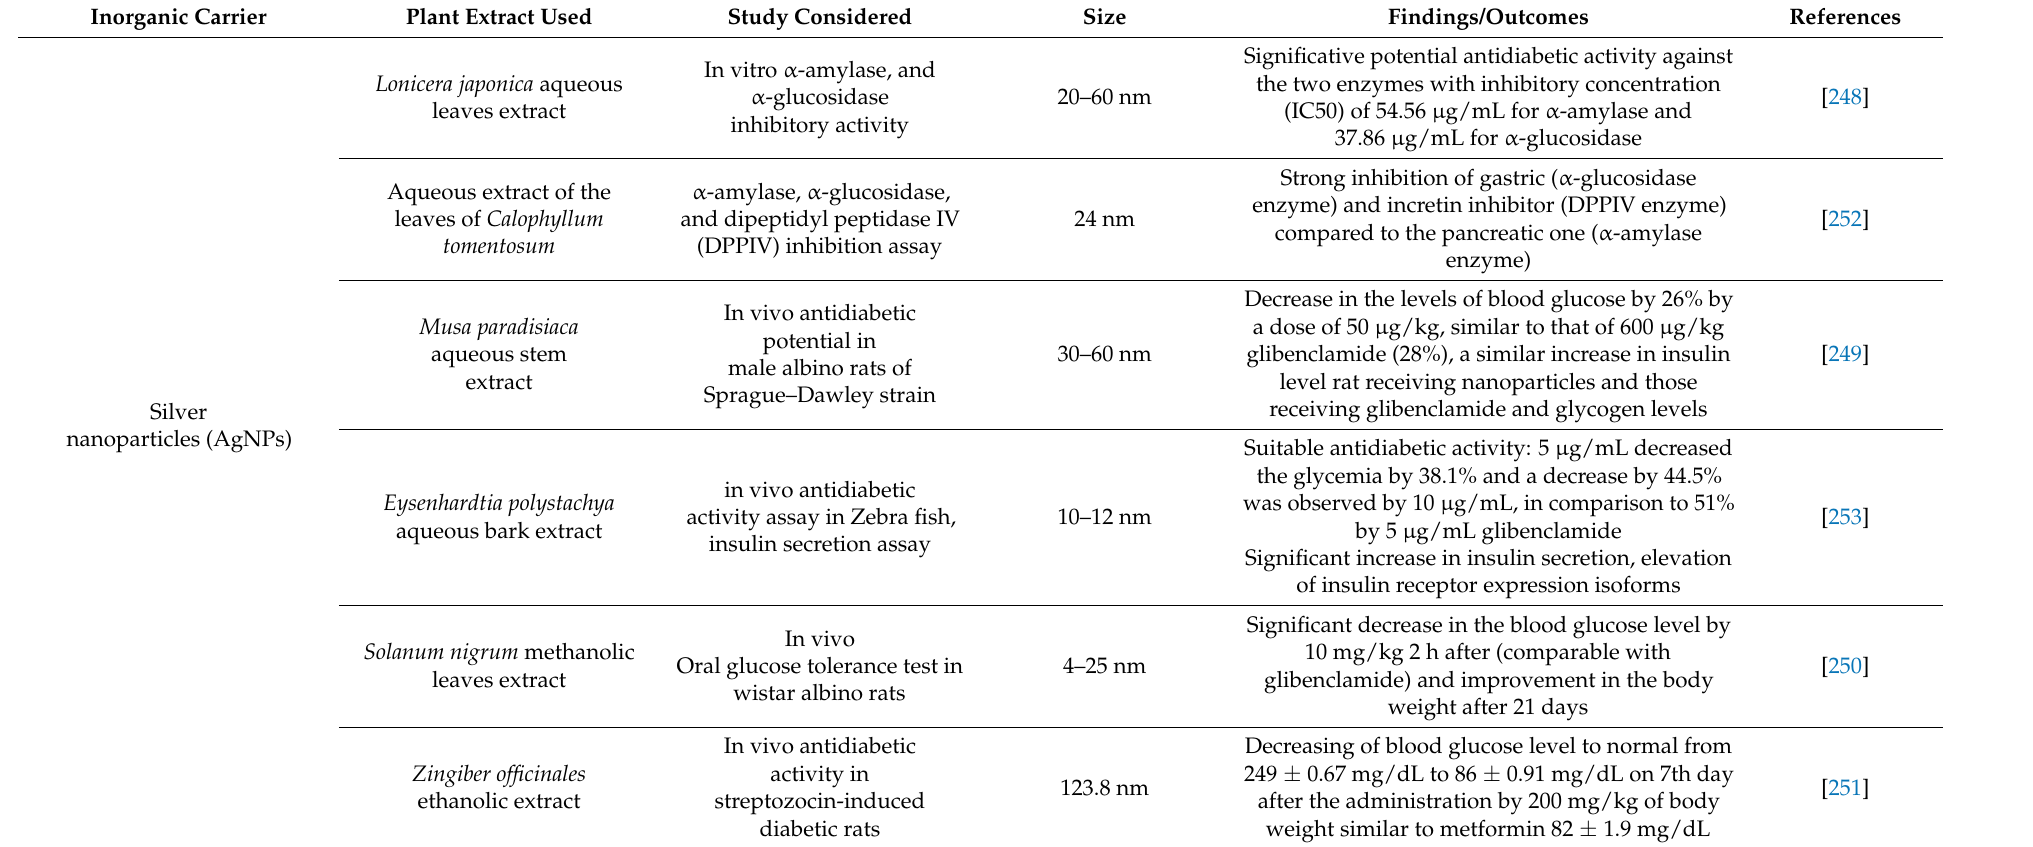
Table 2. Overview of the antidiabetic activities of inorganic-based nanoformulations of antidiabetic plant